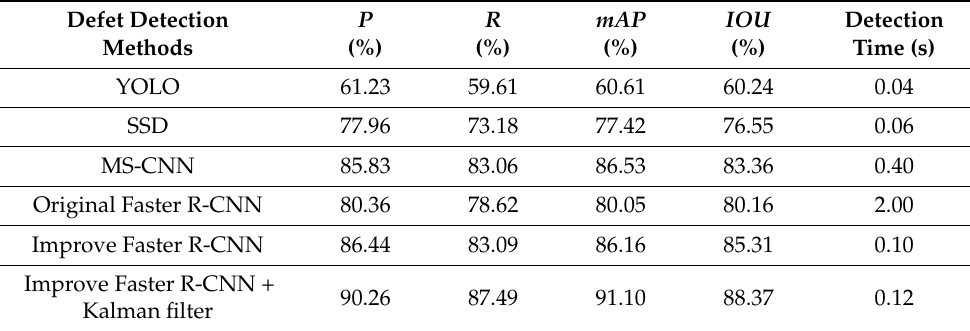
Table 3. Performance comparison of different detection methods.